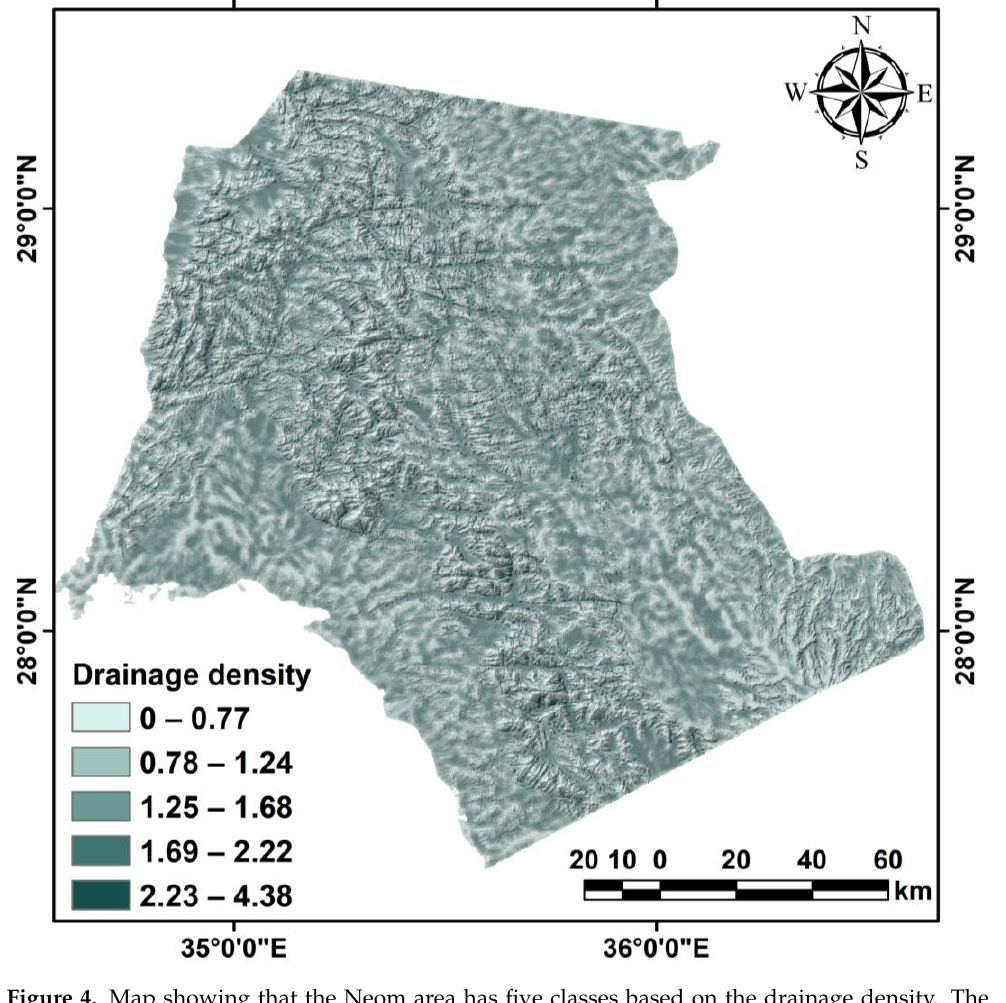
Figure 4. Map showing that the Neom area has five classes based on the drainage density. The smallest class is 0 – 0.77, and the largest is 2.23 – 4.38 km 2